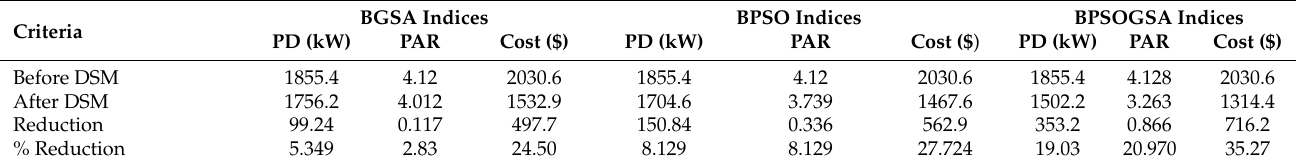
Table 1. Optimized results before and after deployment of DSM